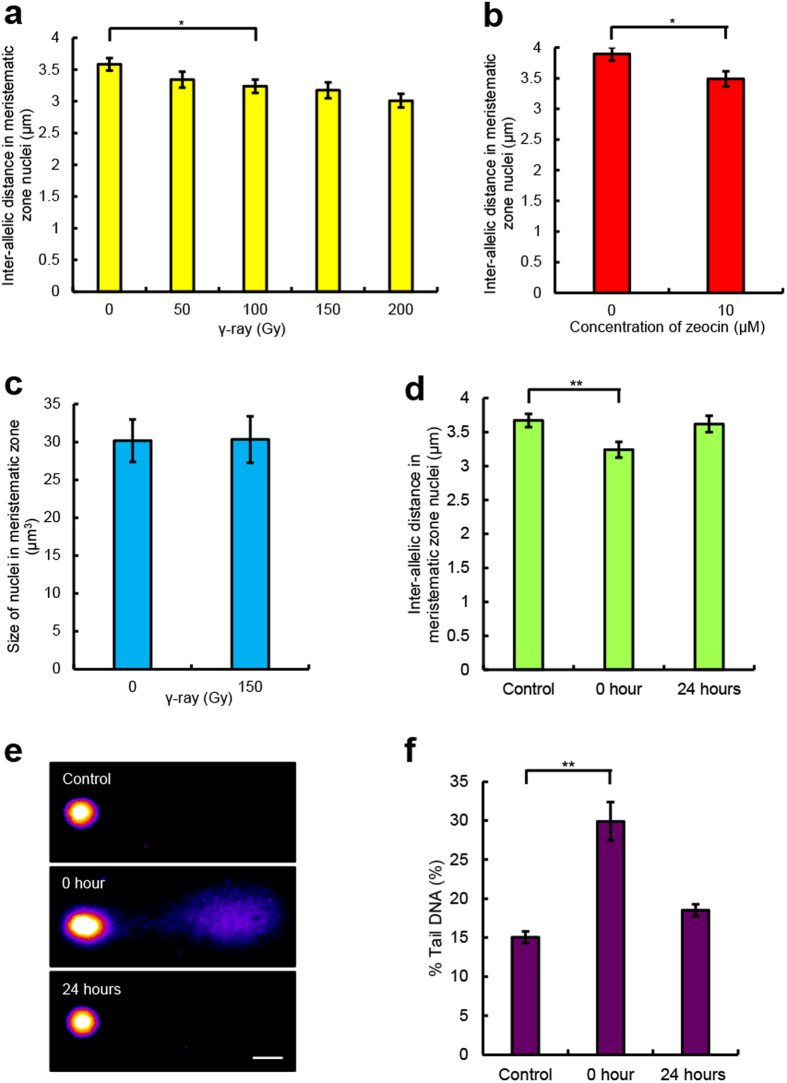
Effect of DNA double-strand breaks (DSBs) on the inter-allelic distance.a,b, Relationship between the inter-allelic distance and dose of γ-irradiation (n > 90, *P < 0.05, a) or 10 μM zeocin (n > 90, *P < 0.05, b,) in the meristematic zone of A. thaliana roots. c, Size of nuclei in the meristematic zone of A. thaliana roots irradiated with 150 Gy γ-irradiation (n = 122, P = 0.35). d, Inter-allelic distance in the meristematic zone nuclei of A. thaliana irradiated with 150 Gy γ-irradiation (n ≥ 90, **P < 0.01). e, Images of comets representing the control nucleus and the nucleus irradiated with 150 Gy γ-irradiation (top, Control; middle, 0 h; bottom, 24 h). Scale bar = 10 μm. f, Levels of DSBs that were detected by a comet assay in A. thaliana roots irradiated with 100 Gy γ-irradiation (n ≥ 70, **P < 0.01).